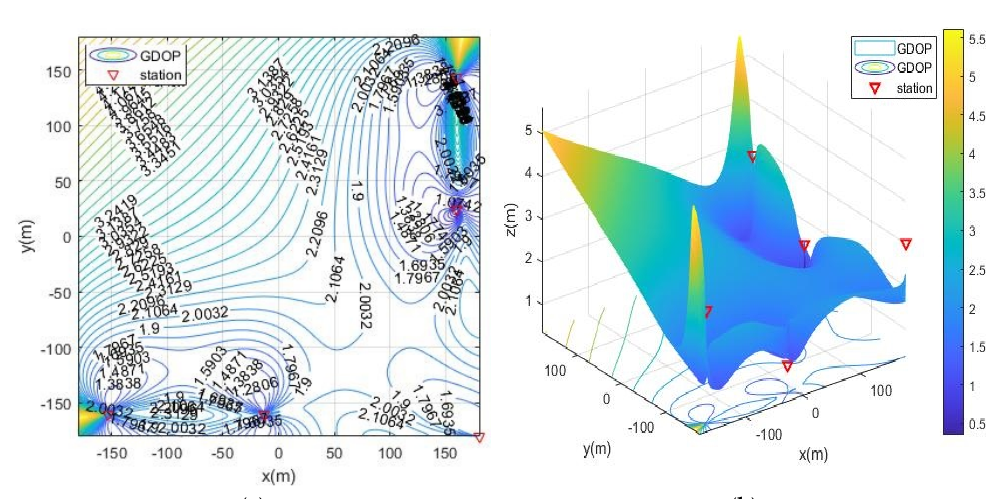
Figure 11. GDOP map of five base stations optimization results with a fixed station (–180, 180, 3). ( a ) 2D contour map of moa05; ( b ) 3D contour map of moa05.